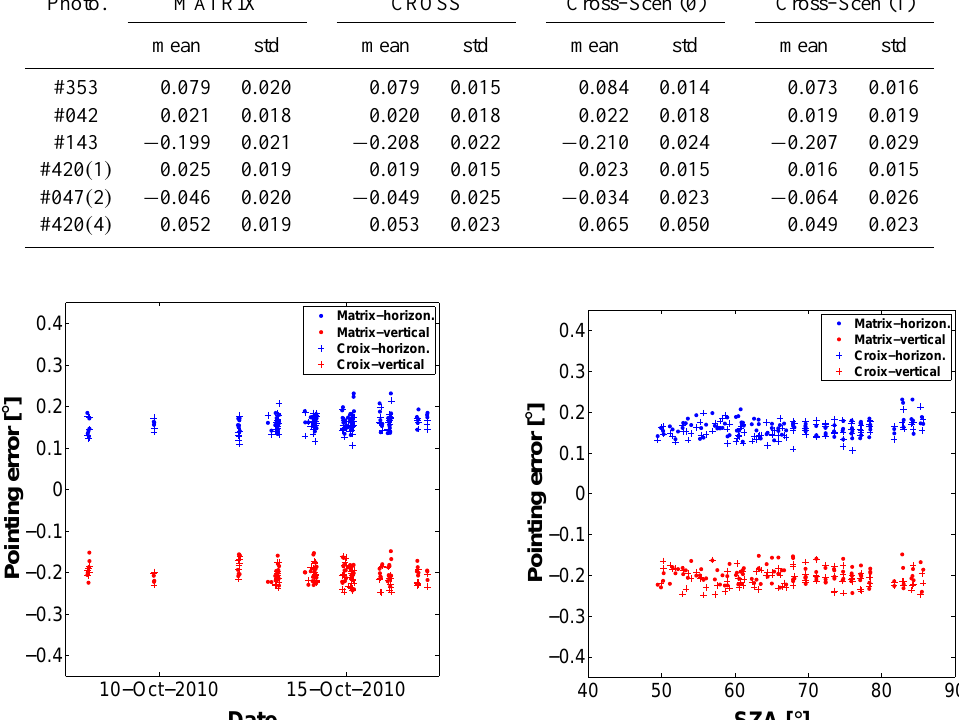
Fig. 8. Estimated center for matrix and cross measurements variation with the date (left) and with the SZA (right) for photometer #143. Table 4. Summary of the horizontal pointing error ( Θ ξ = ξ ϕ sin( θ s ) ) and vertical pointing error ( Θ ξ = ξ θ ), both given in degrees, of ϕ θ photometer #047 . Photo.